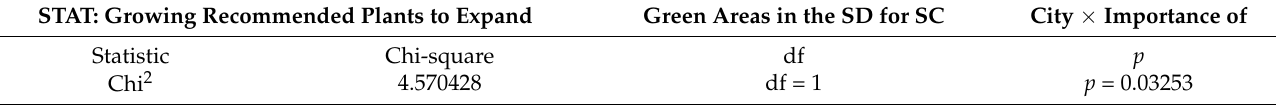
Table 3. The results of the significance level test for two variables: growing recommended plants to expand green areas in the city and importance of SD for SC.